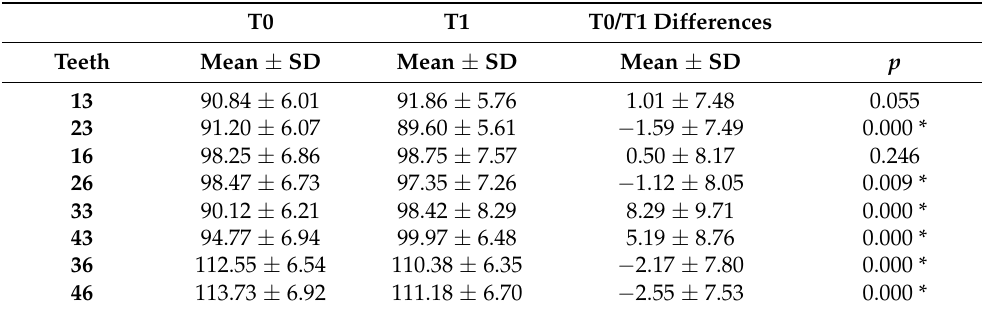
Table 3. Results of T0/T1 angulation changes for all cases.